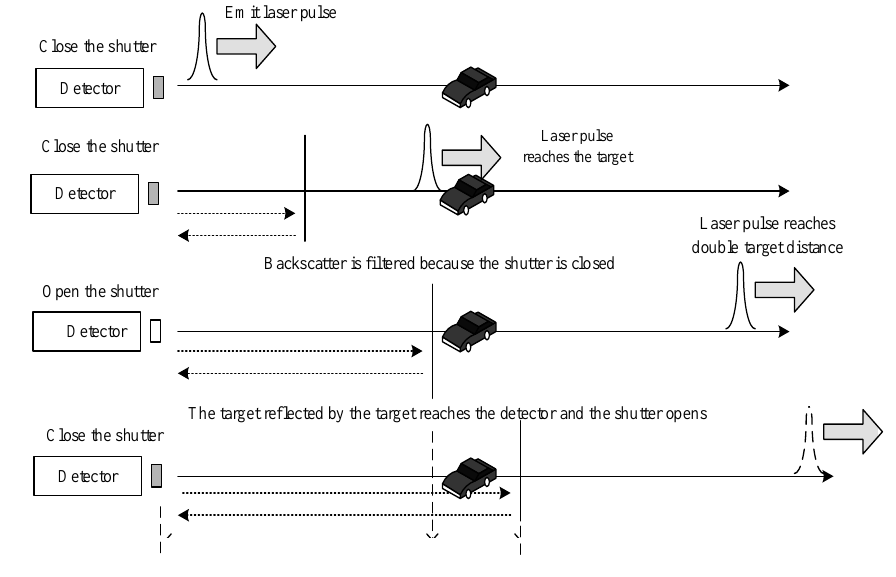
Figure 2. Gated imaging schematic.